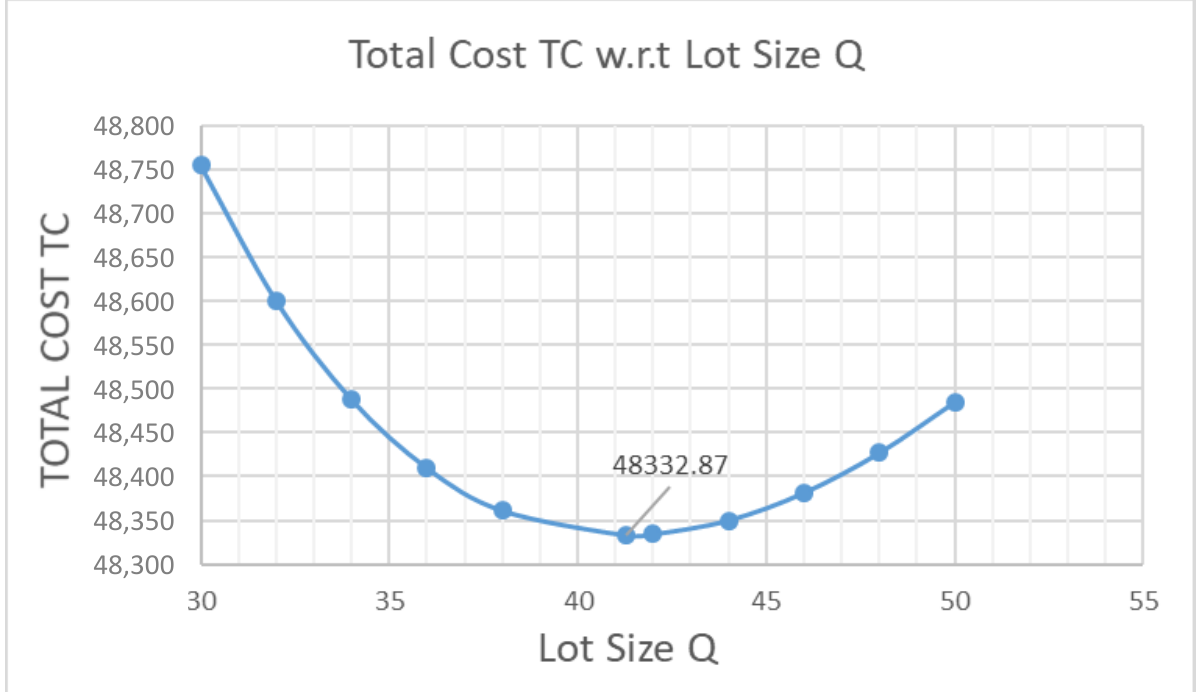
Figure 2. Total cost TC with respect to production lot size Q.